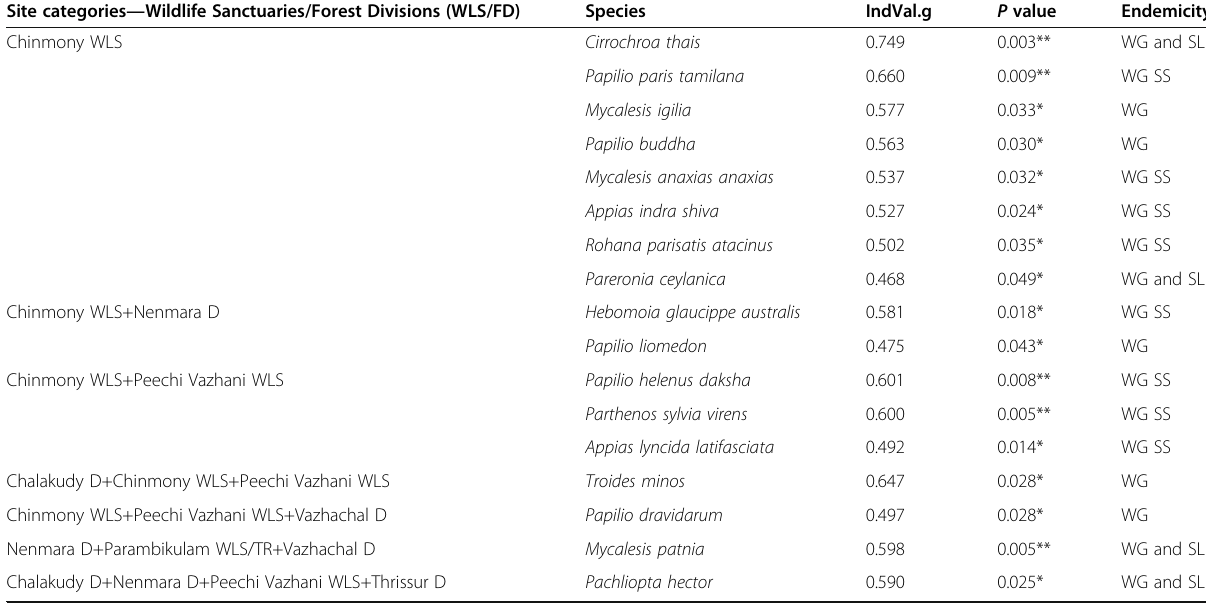
Table 4 Indicator species analysis for all combinations of site categories Site categories — Wildlife Sanctuaries/Forest Divisions (WLS/FD)